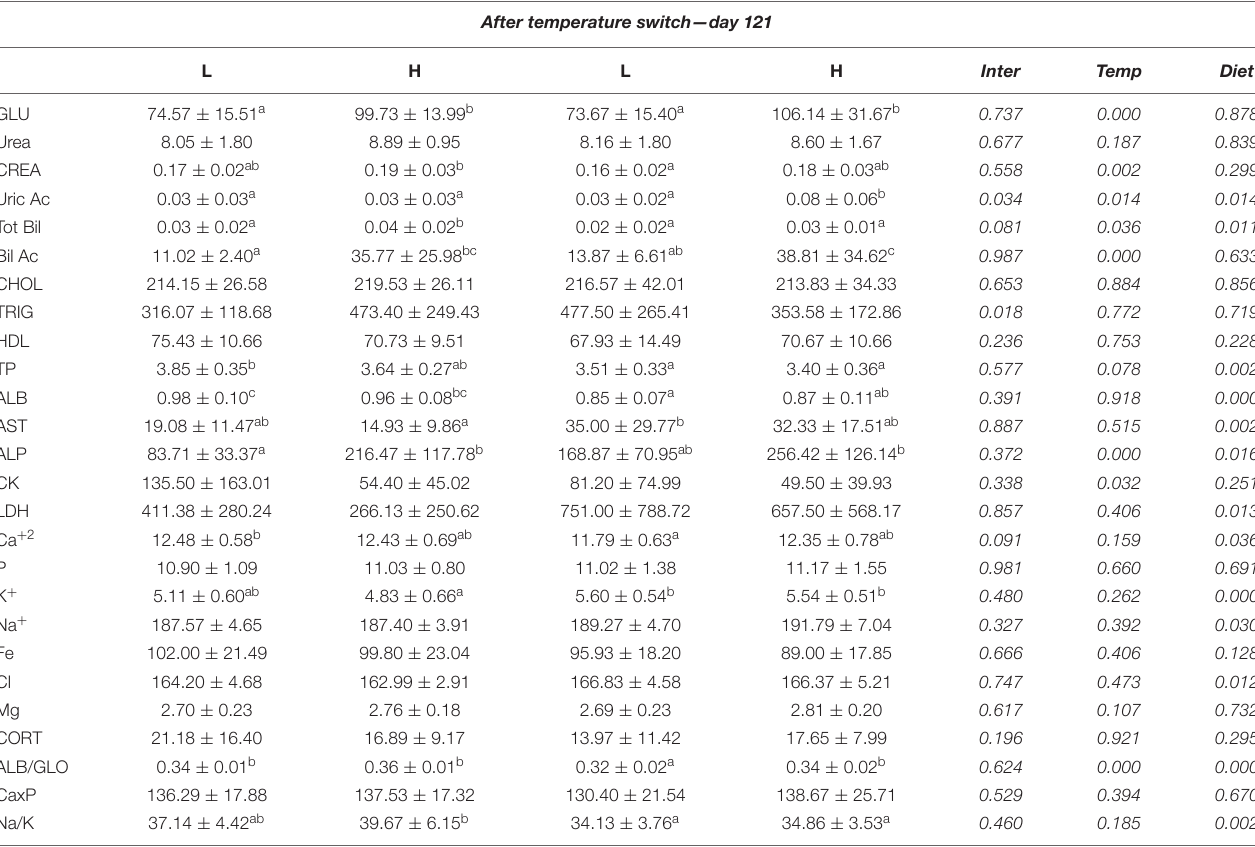
TABLE 5 | Plasma biochemistry values for gilthead sea bream fed the experimental diets and exposed to two different temperatures after temperature switch. After temperature switch—day